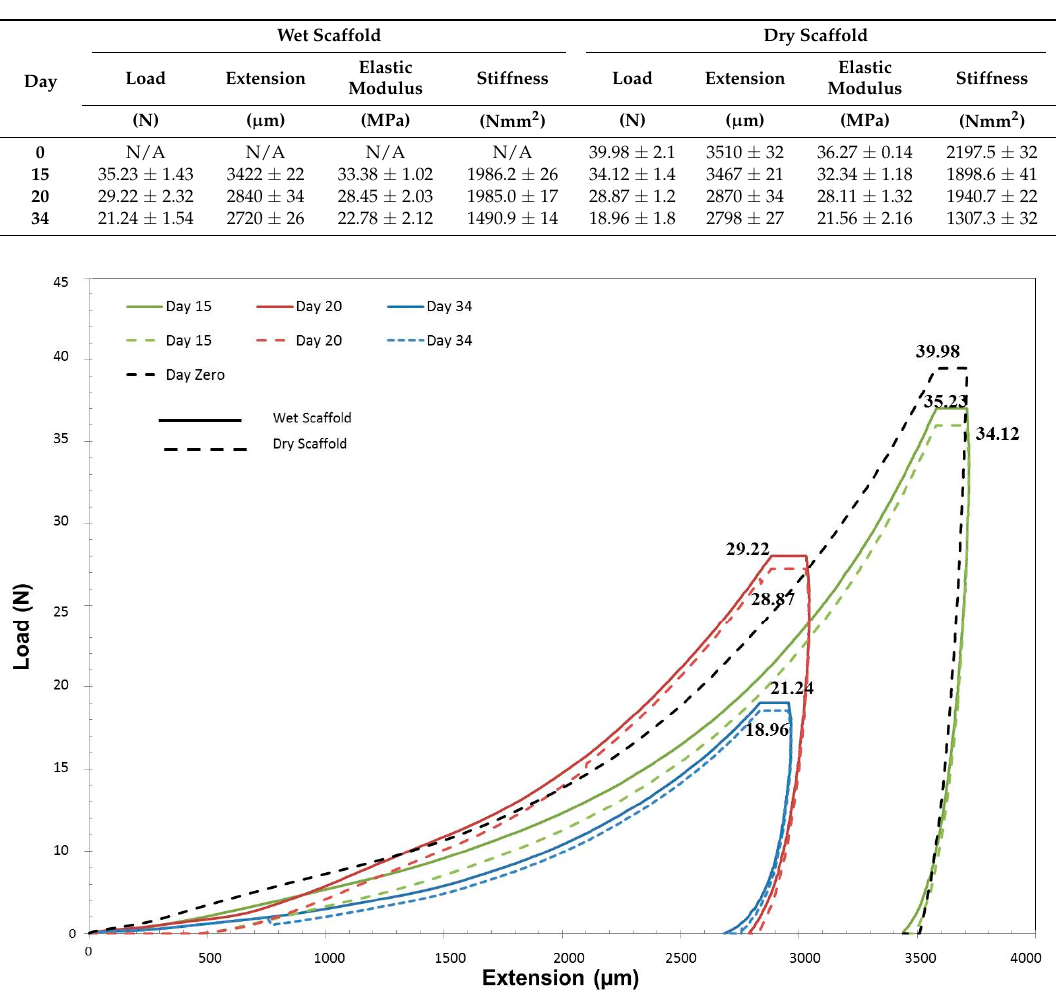
Table 7. Macro-indentation test result for 3D optimum scaffold after cell seeding.